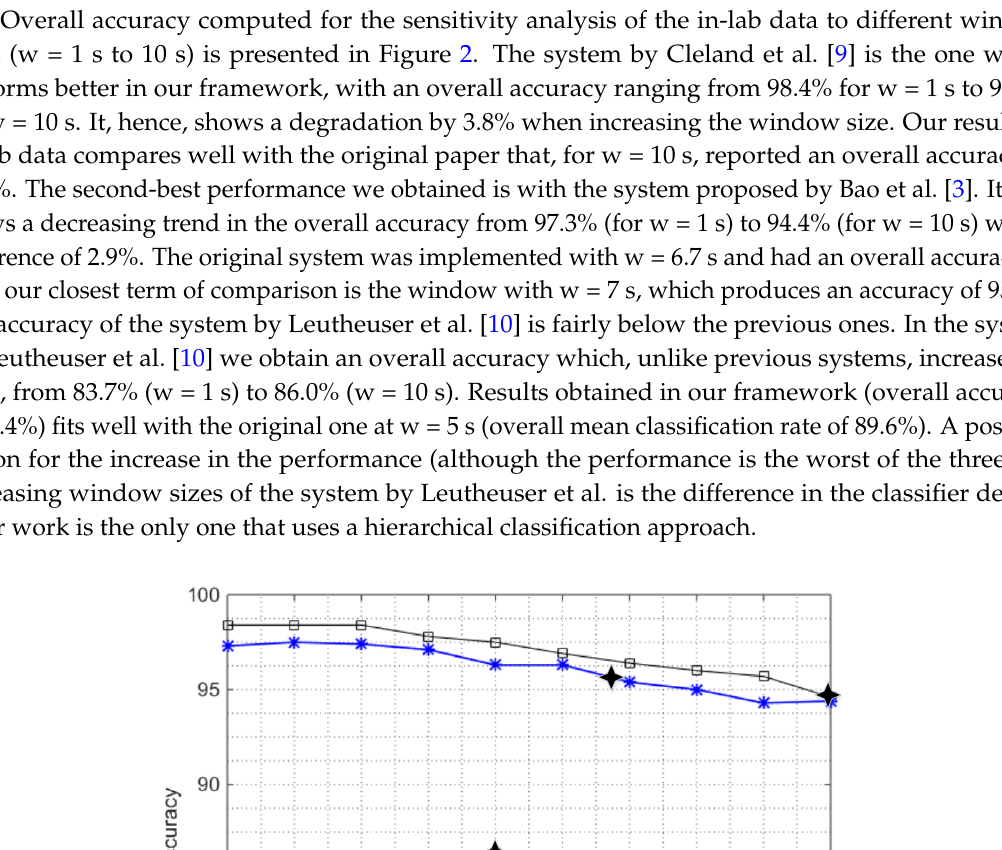
Figure 2. Sensitivity analysis of overall accuracy of in-lab data when window size is increased from w = 1 s to w = 10 s using sensor set S IN (Table 4). The symbol ( ) specifies the window size used in the original PAC system by the authors.